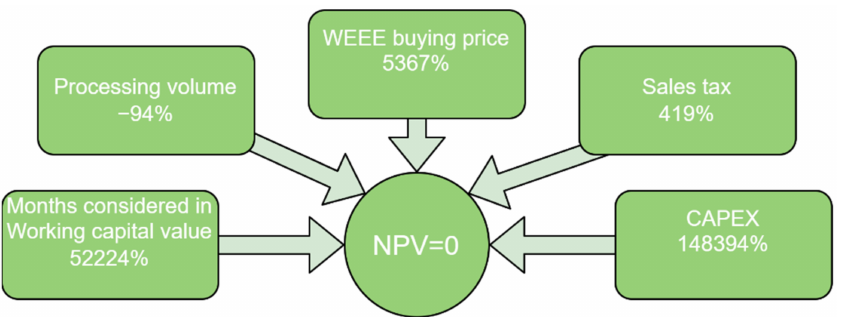
Figure 8. Sensitivity Analysis to reset the NPV of the Case